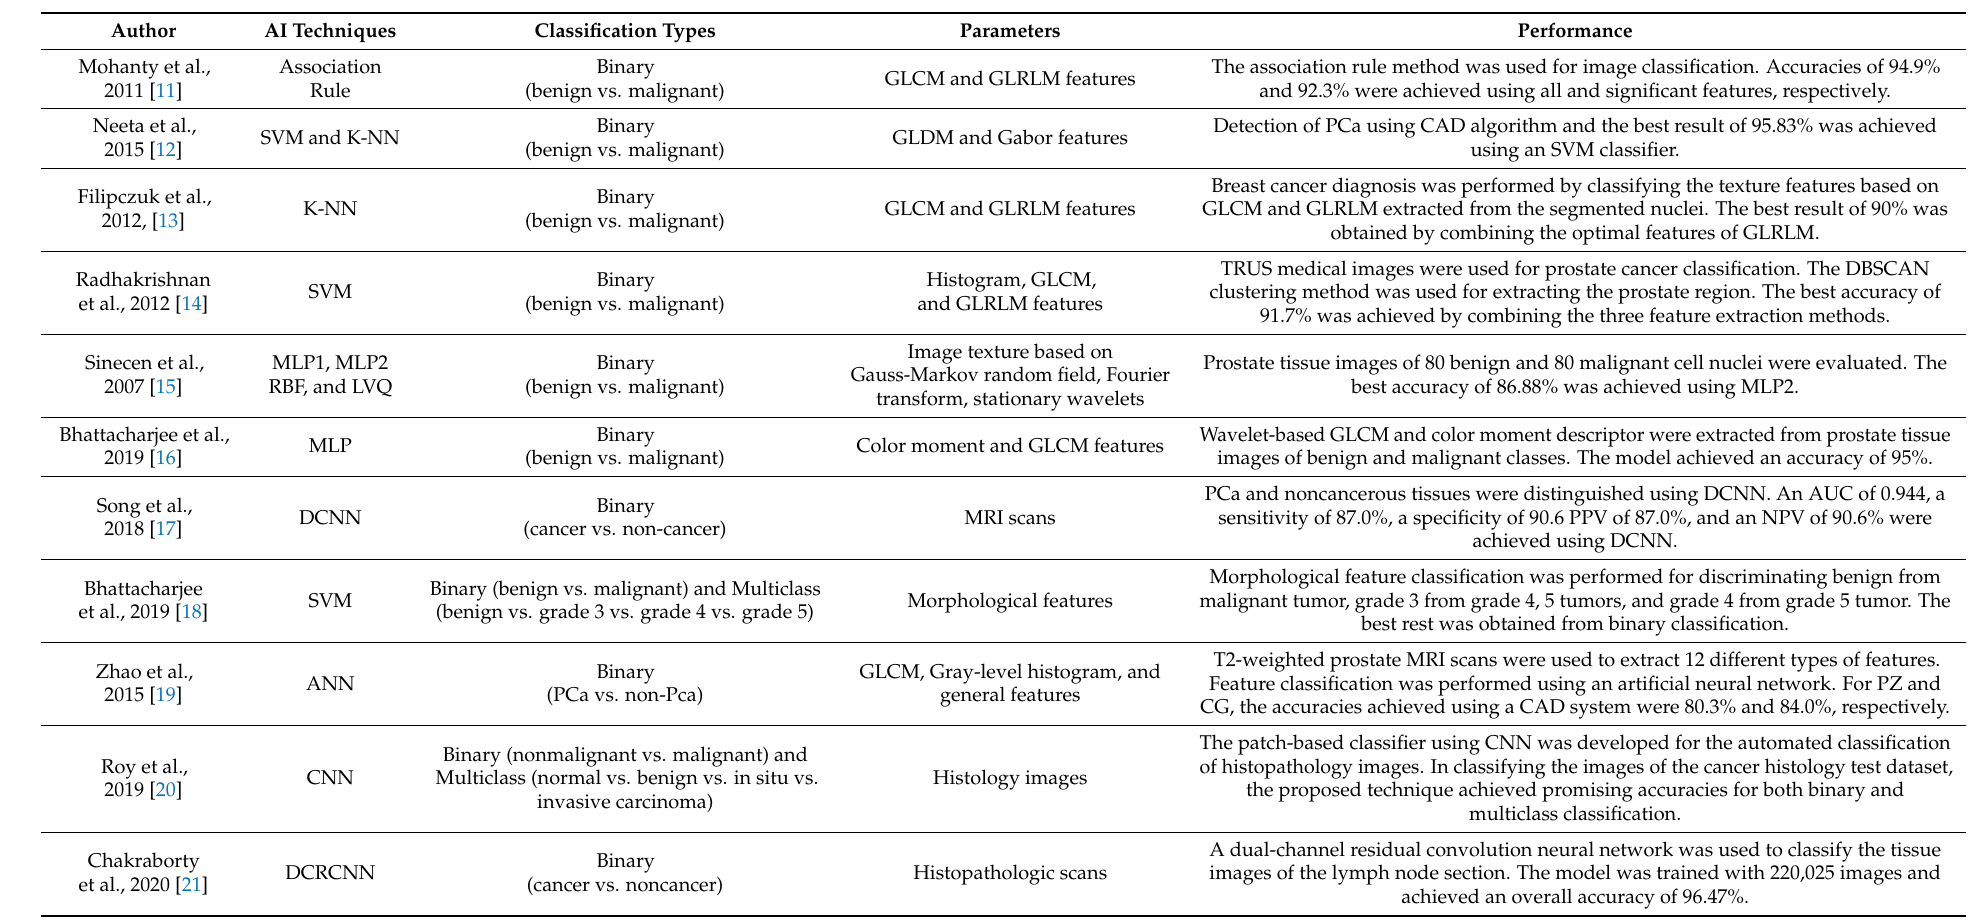
Table 1. Past studies related to cancer detection using artificial intelligence (AI)